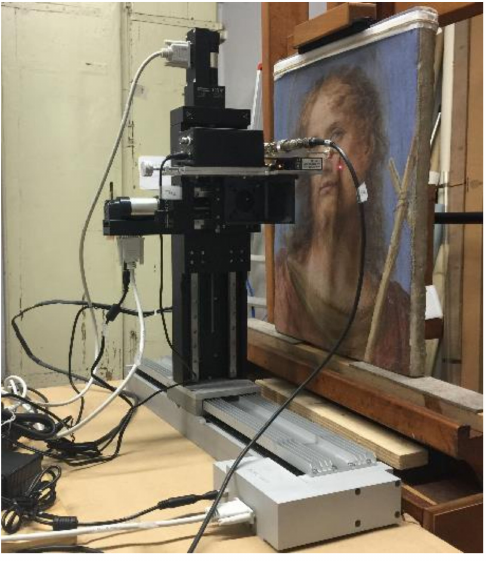
Figure 16. Acquisition of the data on the Gherardini artwork using the new THz imaging